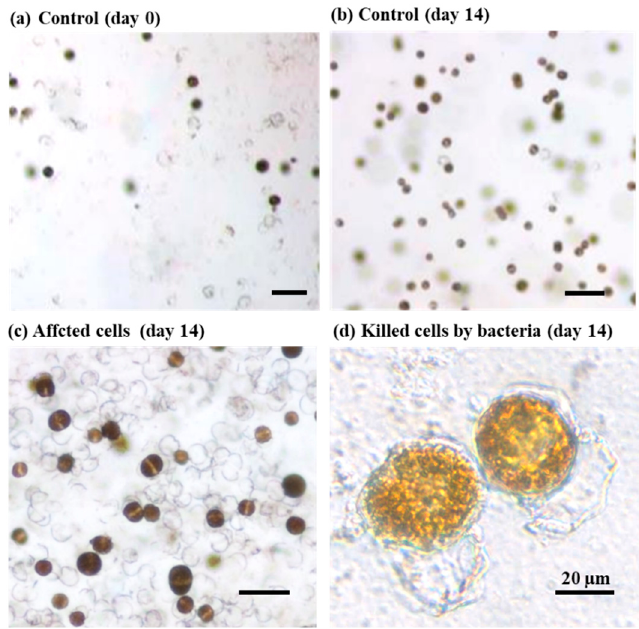
Figure 9. Photomicrographs showing the growth-inhibiting activities of bacteria against the toxic dinoflagellate Alexandrium catenella (Group I). ( a ) The control cells on day 0, ( b ) the control cells on day 14, ( c ) the cells on day 14 affected by growth-inhibiting bacteria, and (d) the cells killed by bacteria. Scale bars: 100 µm, except for panel ( d ).